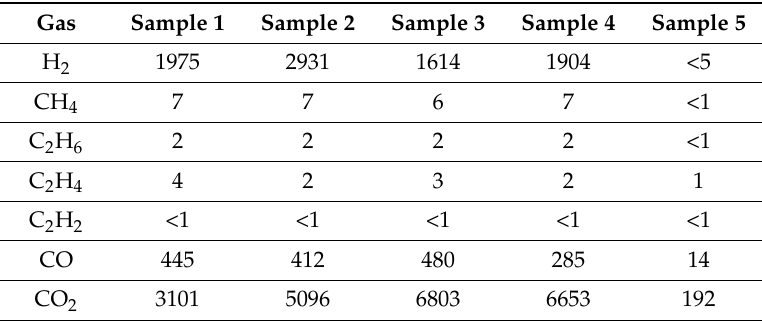
Table 7. DGA history of transformer 2.